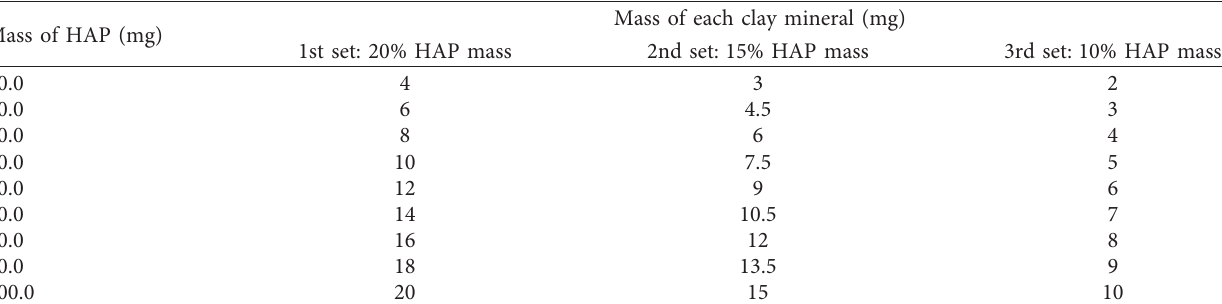
Table 1: Experimental batches for HAP-clay